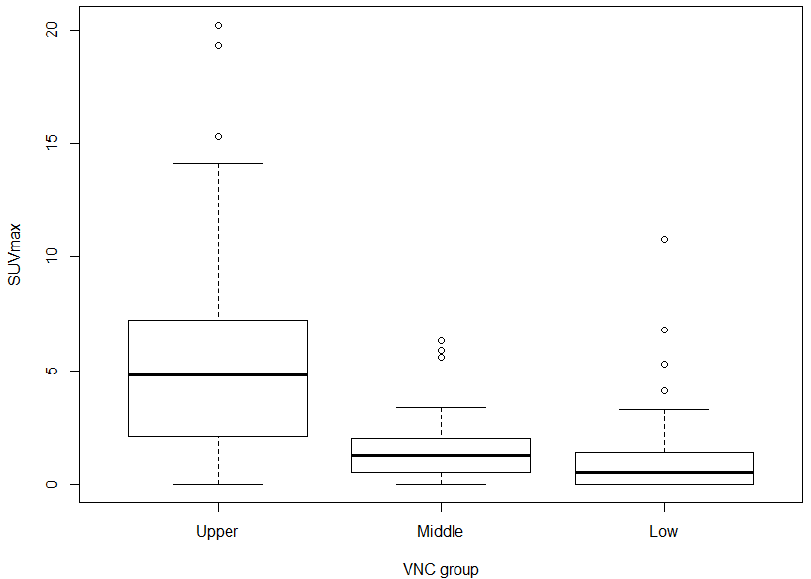
Figure 3. Distribution of SUVmax for each VNC group. SUVmax of lung adenocarcinomas catego- rized according to VNC group ( p < 0.0001). The boxes extend from the 25th percentile to the 75th percentile, and the whiskers extend to 1.5 times the interquartile distance.